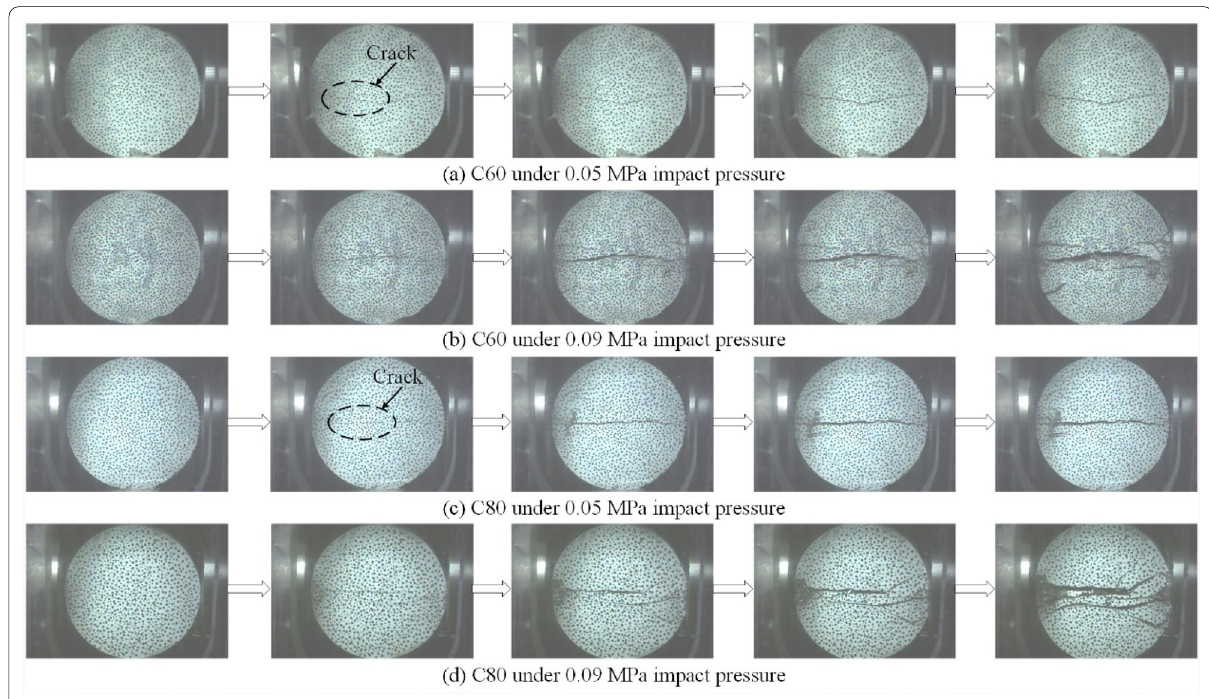
Fig. 6 Crack propagation morphologies of C60 and C80 under different impact pressure.